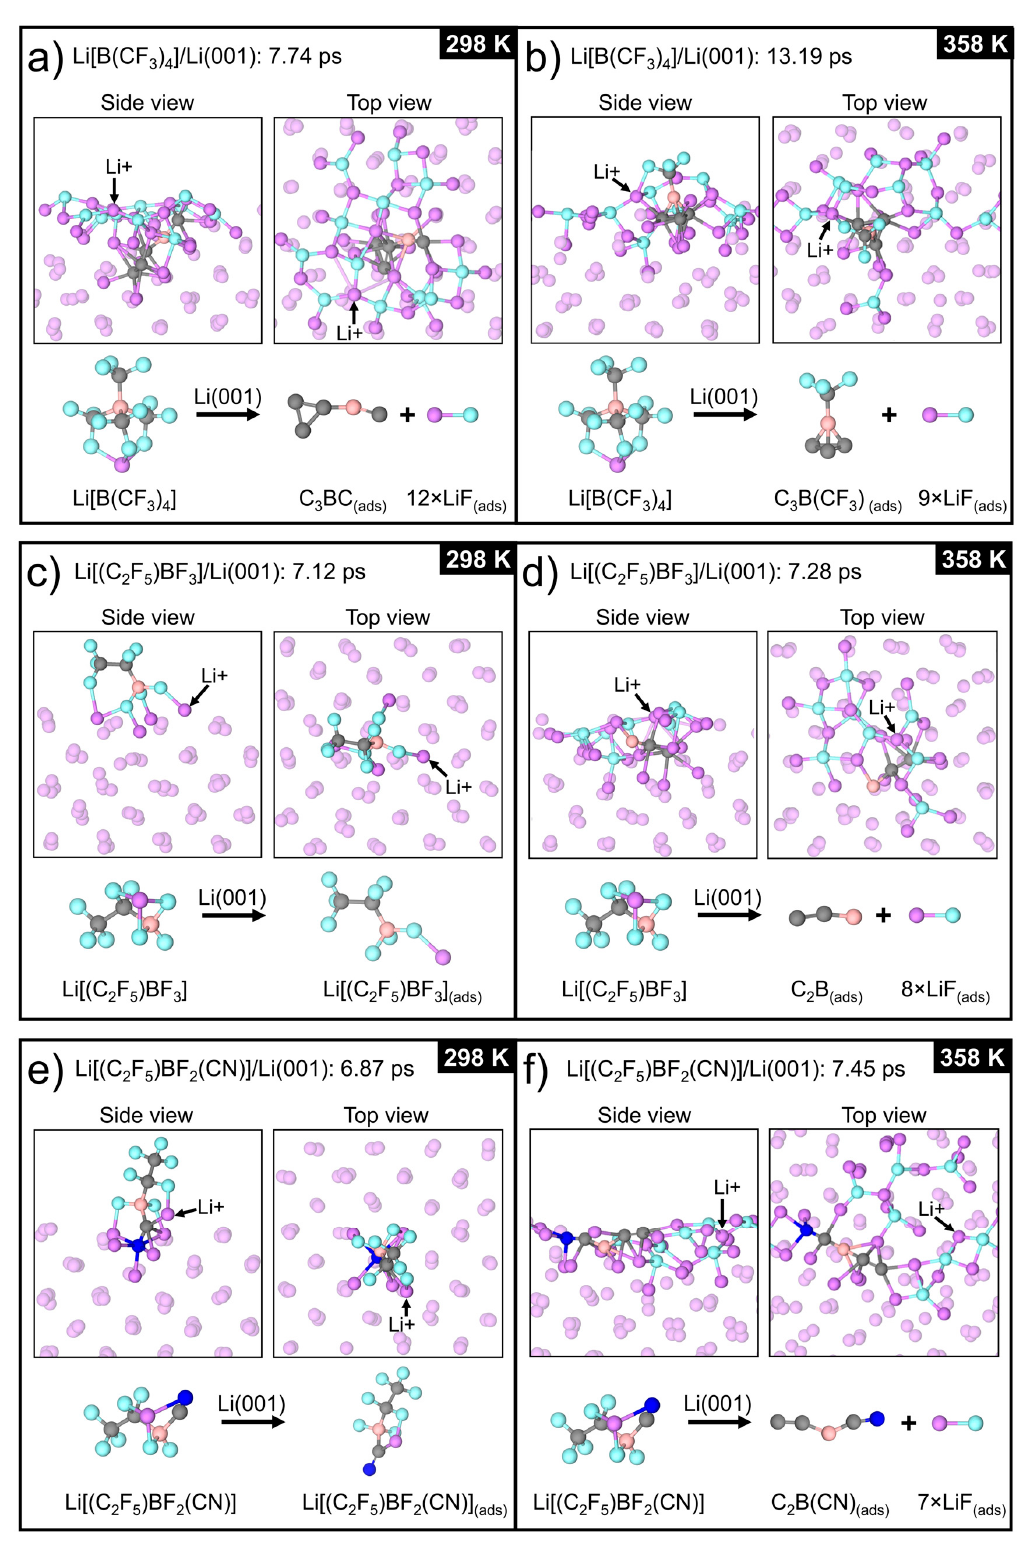
Figure 6. Snapshots of the final structure of the ab initio molecular dynamics (AIMD) simulations of the three different Li-salt/Li(001) systems at room temperature (298 K) ( a , c , e ) and elevated temperature (358 K) ( b , d , f ).